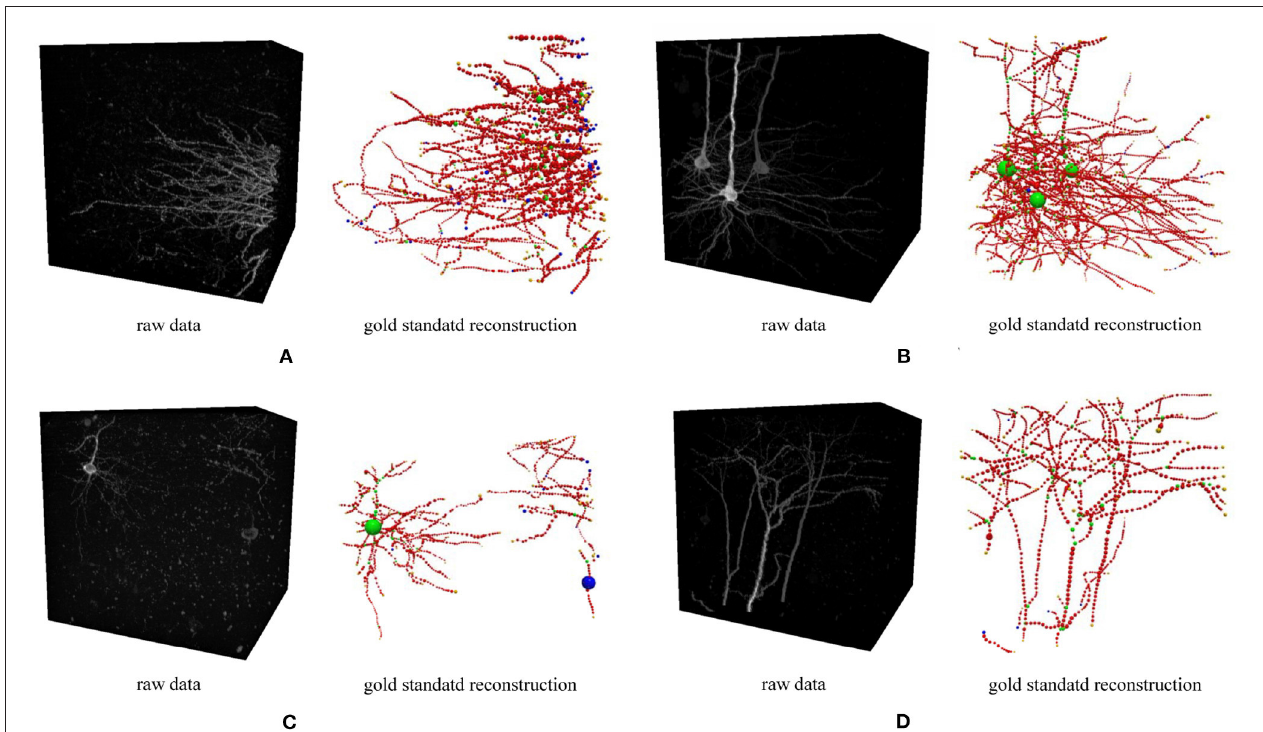
FIGURE 5 | Four 3D neuron images used in the optimization experiment. Each image and its gold standard reconstruction is rendered side by side in each panel labeled by the corresponding dataset ID. (A) FM3, (B) FM4, (C) FM5, and (D) FM6.